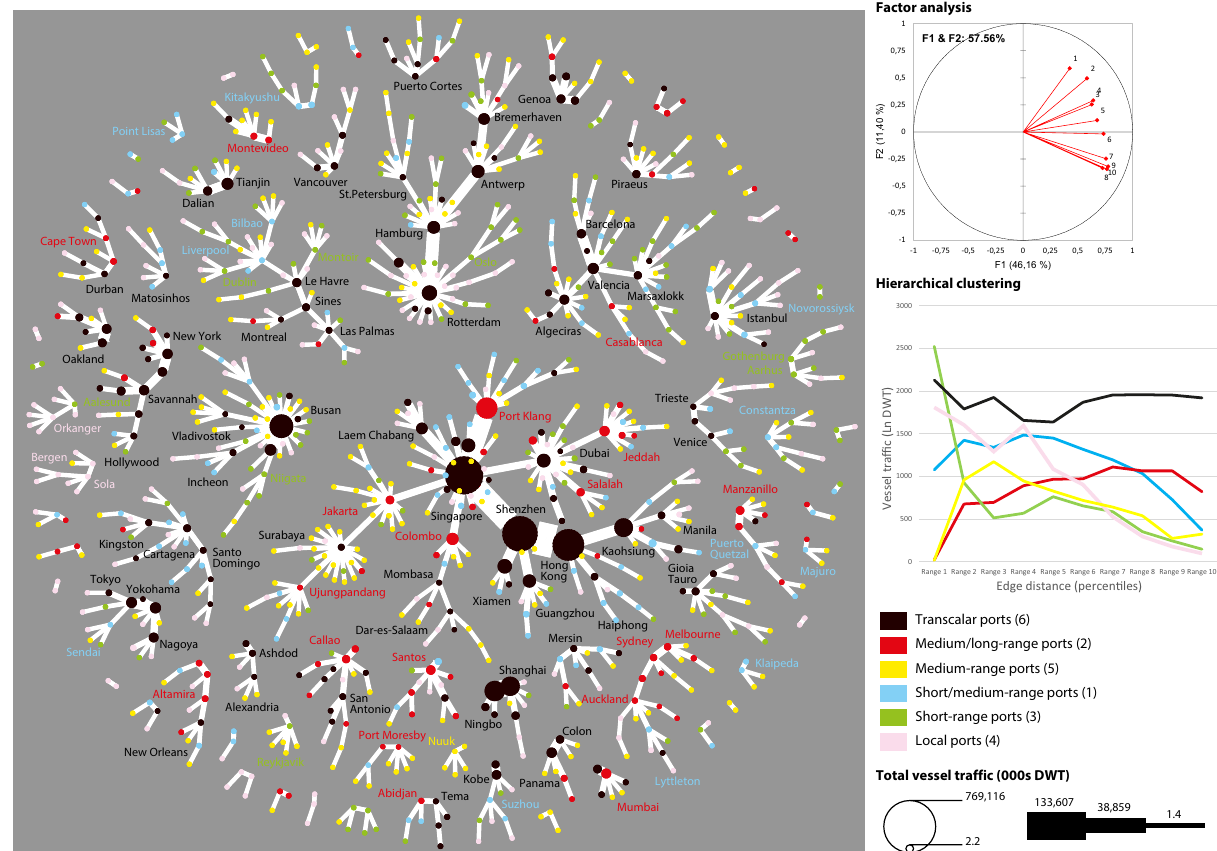
Figure 4. Multivariate analysis and visualization (space-L) of the GCSN (own elaboration based on TULIP 3.0.0; https:// tulip. labri. fr/ site/?q= node/